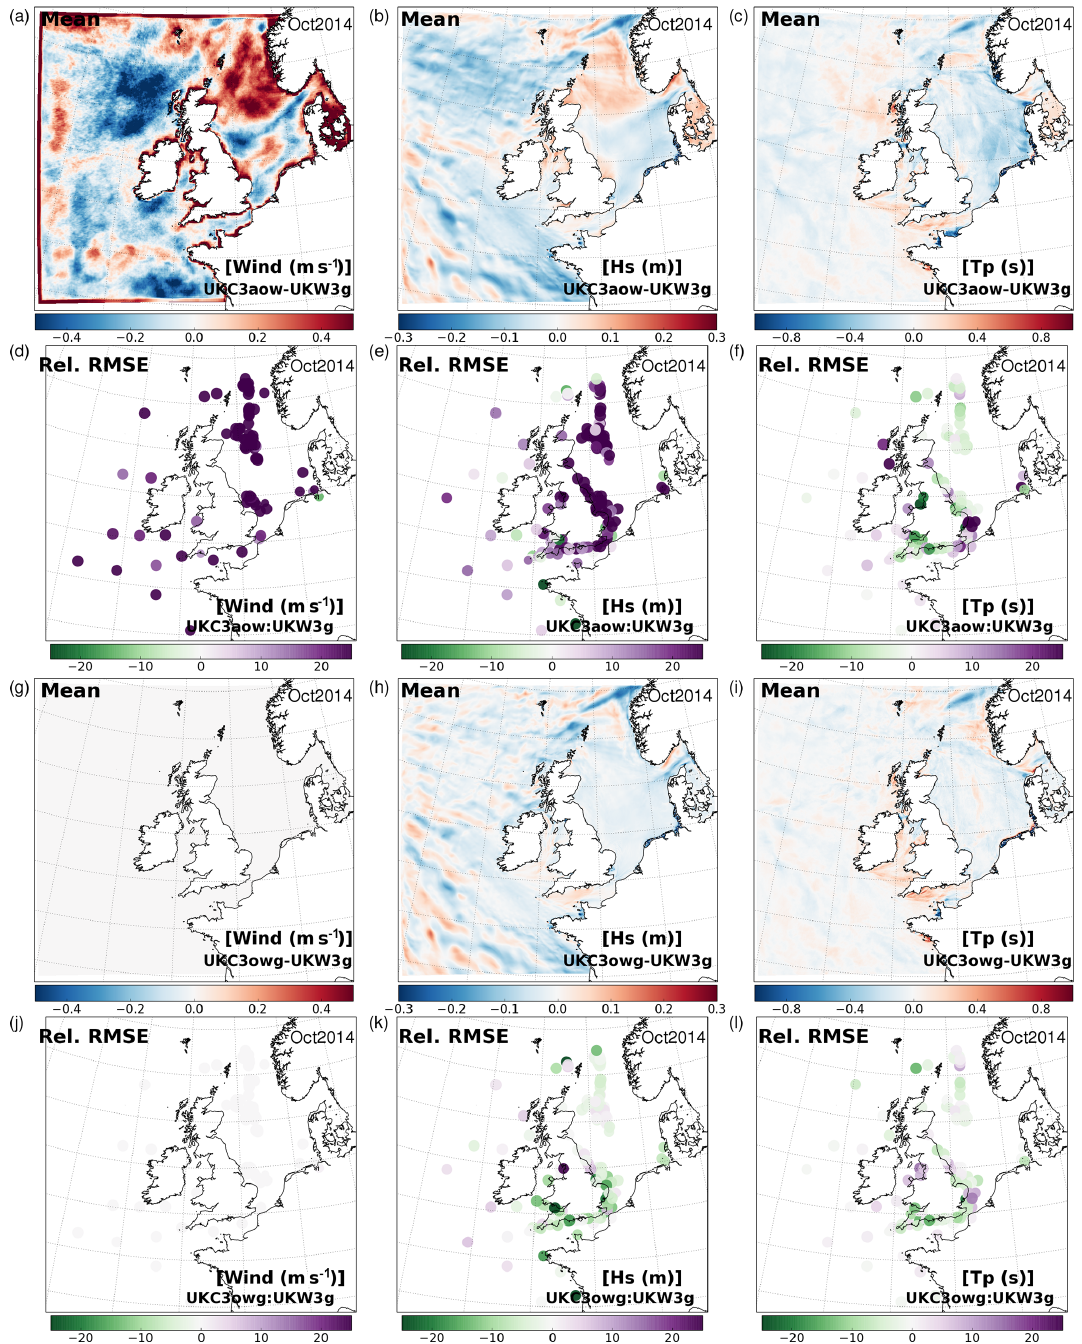
Figure 5. Sensitivity of wave model wind forcing, significant wave height ( H s ) and peak wave period ( T p ) to coupling during October 2014 experiment. Monthly mean differences between UKC3aow and UKW3g for (a) coupled/forced atmosphere winds, (b) significant wave height H s and (c) peak wave period T p . (d–f) Percentage difference in RMSE statistic for UKC3aow results relative to UKW3g for ( d) wind forcing, (e) H s , (f) T p . (g–i) Monthly mean differences between partially coupled UKC3owg and UKW3g (i.e. with same global-scale wind forcing) for (g) wind forcing, (h) H s , (i) T p , and (j–l) percentage difference in RMSE statistics for each variable for UKC3owg relative to